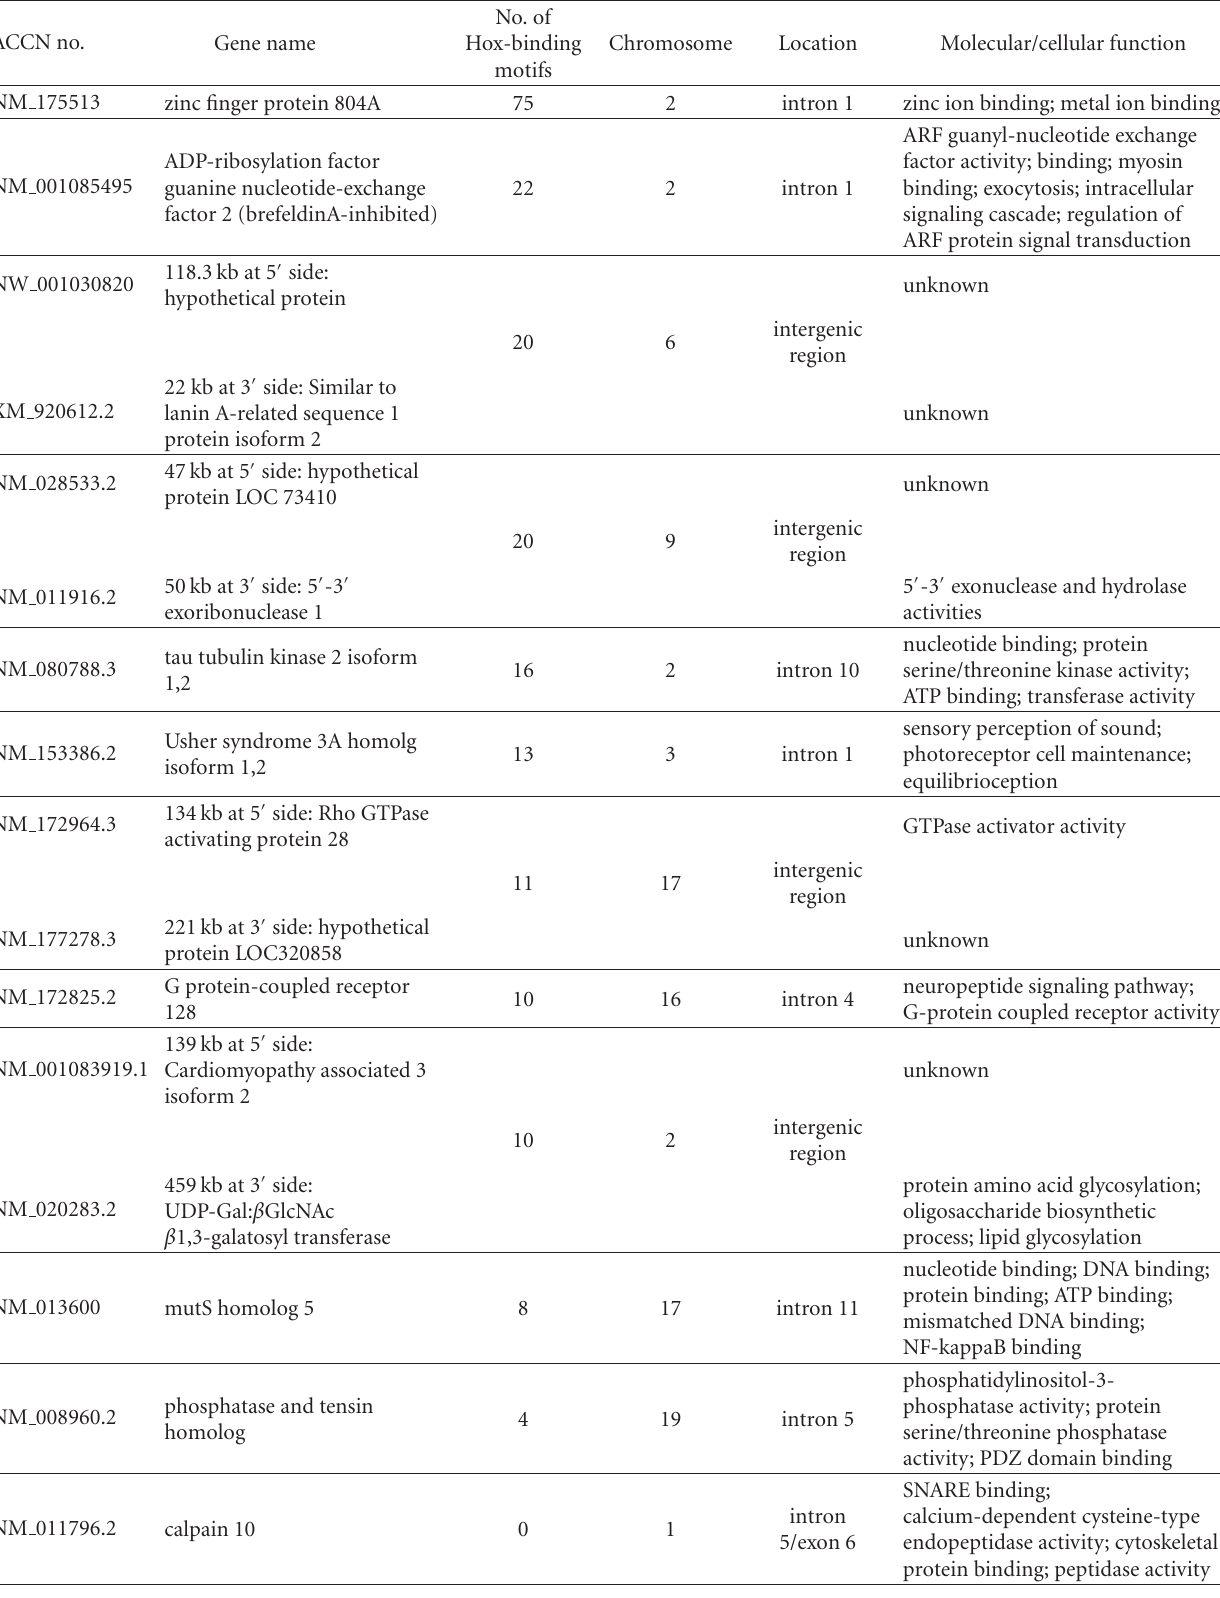
Table 1: Candidate downstream targets of Hoxc8 from ChIP-cloning. Referred to Chung HJ et al. [10]. ACCN